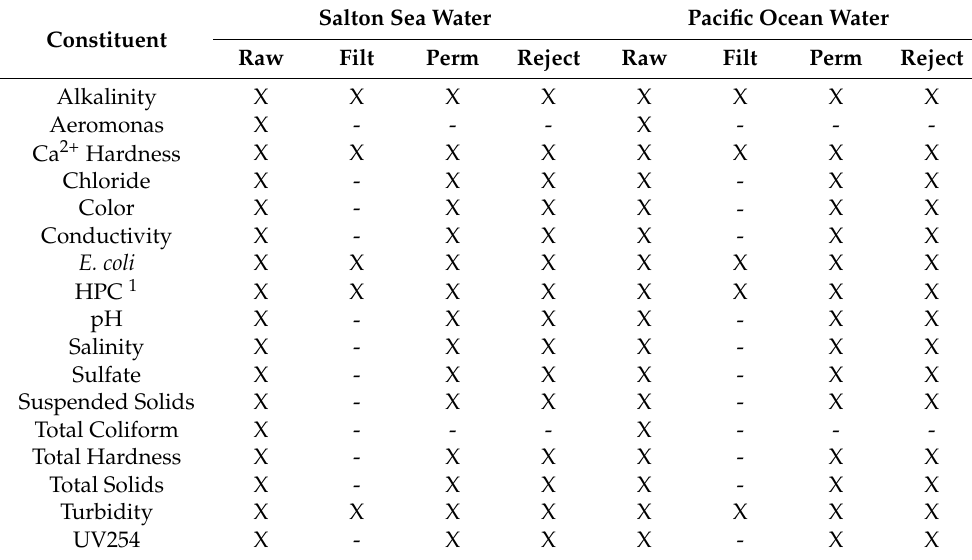
Table 1. Sampling and Analysis Plan 1 .